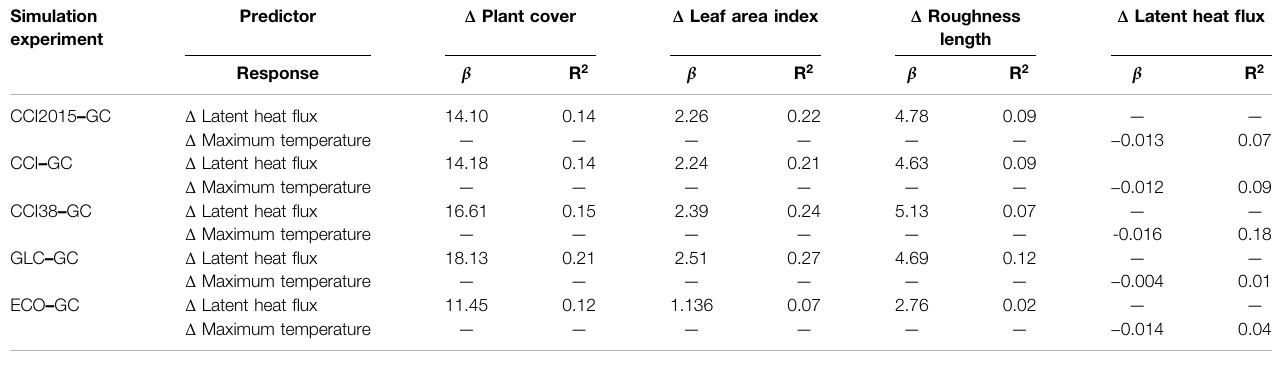
TABLE 4 | Linear regression fi t statistics for coef fi cient β and goodness-of- fi t R 2 values between differences (experiment — control) in plant cover, leaf area index, roughness length as predictors and differences in latent heat as responses, and between differences in latent heat as predictor and differences in maximum temperature as responses. All regression coef fi cients are statistically signi fi cant at p < 0.05. These statistics are calculated for each simulation experiment. Please see Table 1 for abbreviations of simulation experiments. Analysis is over the vegetation period (April to September).